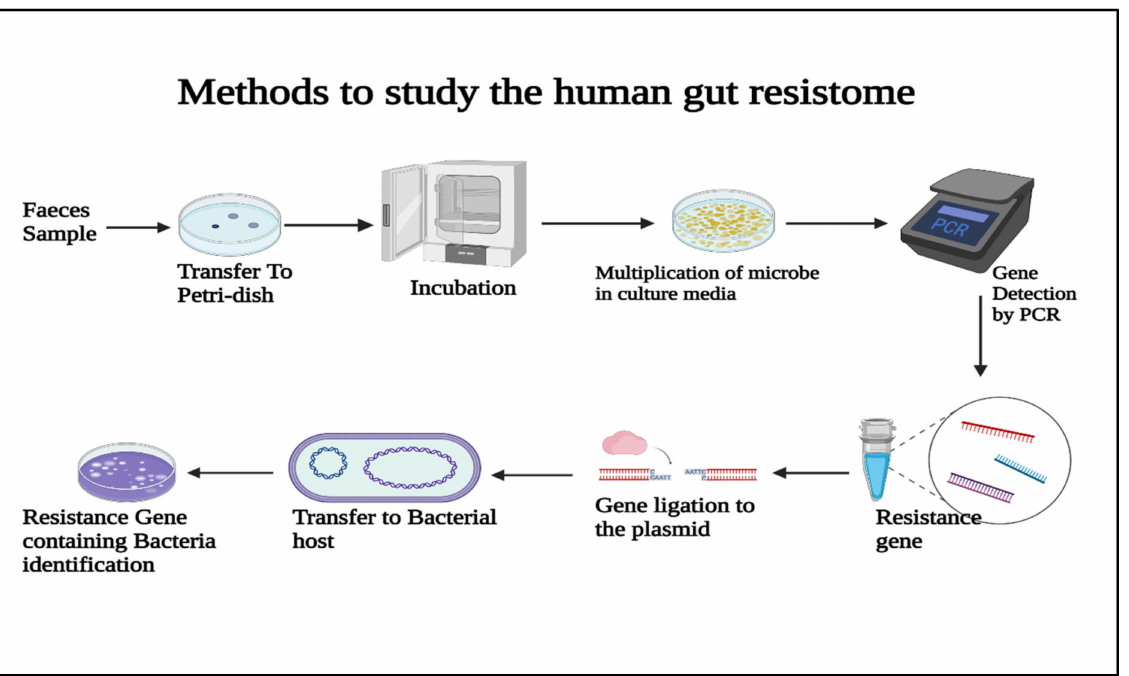
Figure 2. Human gut resistome identification procedure from feces sample that contains resistance gene